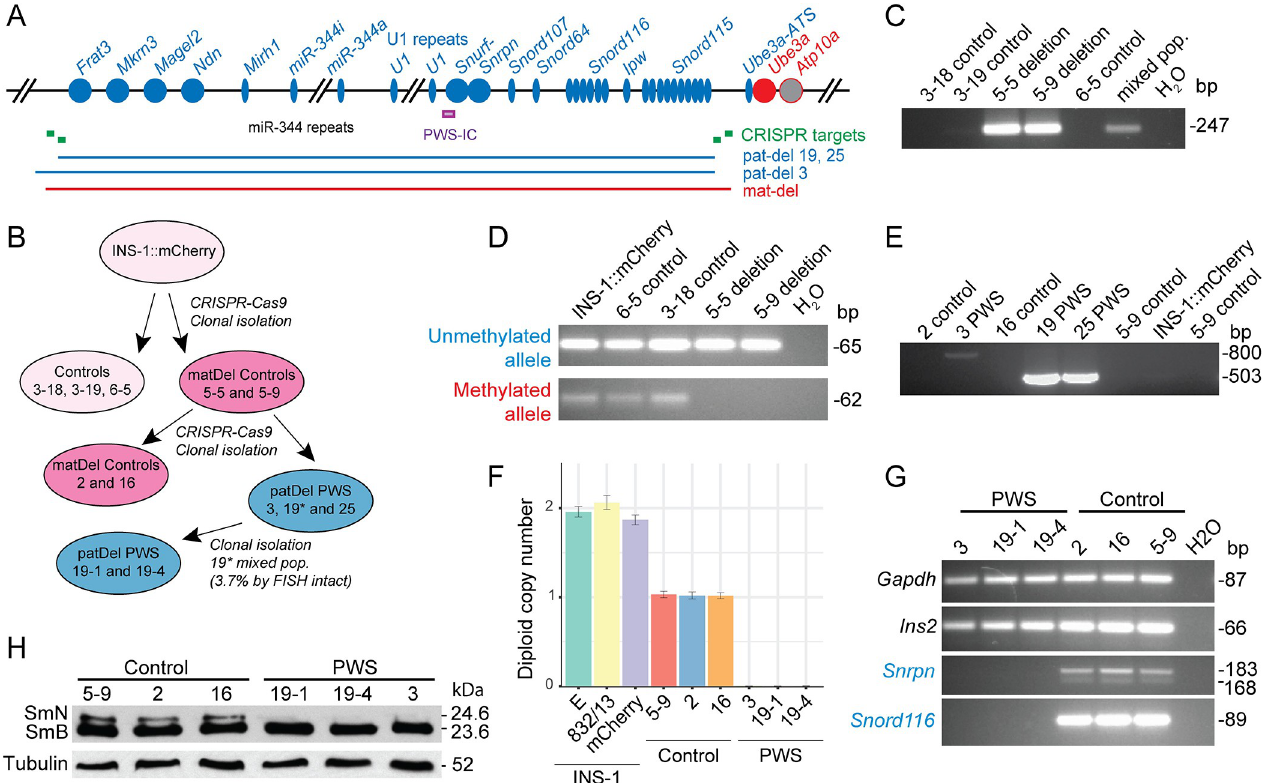
Fig 1. CRISPR/Cas9 genome editing to generate INS-1 lines with 3.16 Mb deletions of the silent (maternal) and active (paternal) PWS-imprinted domain. (A) Gene map of the rat PWS-imprinted domain and CRISPR/Cas9-targeted deletions. Symbols: circles, protein-coding genes; thin ovals, RNA genes; blue, (paternal; pat) and red (maternal; mat), imprinted genes; IC, imprinting control region (purple bar); green boxes, CRISPR gRNA target sites; blue and red horizontal bars, extent of deletions. Not all copies of tandemly repeated loci ( miR-344 ; U1, Snord116 , Snord115 ) are shown. (B) Schematic showing generation of genome edited, clonal INS-1 lines with 3.16 Mb deletions on the silent maternal allele only (5–9, 2, 16; dark pink) or homozygous deletion of both maternal and active paternal alleles (3, 19–1, 19–4, 25; blue). (C) First round deletion-PCR on genomic DNA identifies two INS-1 lines with deletions (5–9, 5–5). The deletion breakpoint is also detected in DNA from a heterogenous population of transfected cells (mixed pop.). (D) DNA methylation analysis of bisulfite- modified genomic DNA at the PWS-IC establishes that lines 5–5 and 5–9 have deletions on the maternal allele. (E) Second round deletion-PCR identifies three INS-1 lines (3, 19, 25) with deletions on the paternal allele, with line 3 having an alternate proximal breakpoint. (F) Gene dosage of Snord107 normalized to Ube3a as determined by ddPCR using genomic DNA from the INS-1 panel of cell lines (also see S9 Fig ). (G) PWS-deletion lines (3, 19–1, 19–4) lack mRNA expression of the PWS-imprinted genes, Snrpn and Snord116 , as detected by RT-PCR, whereas control lines (5–9, 2, 16) express PWS-imprinted genes. All cell lines express the control genes ( Gapdh , Ins2 ). The full panel of PWS-imprinted genes is shown in S10A and S10B Fig (H) Use of whole cell extracts for a western blot shows that PWS-deletion lines (3, 19–1, 19–4) lack expression of the spliceosomal SmN polypeptide (24.6 kDa) encoded by Snrpn , but retain expression of the paralogous SmB polypeptide (23.6 kDa) encoded by the unlinked Snrpb gene. The control is α